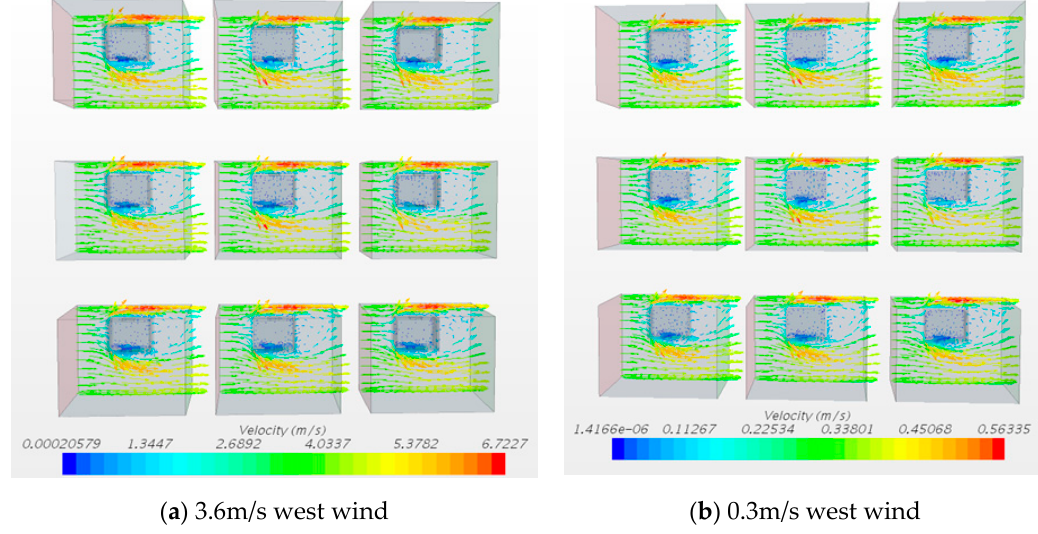
Figure 14. Wind speed change result. ( a ) 3.6m/s west wind ( b ) 0.3m/s west wind.